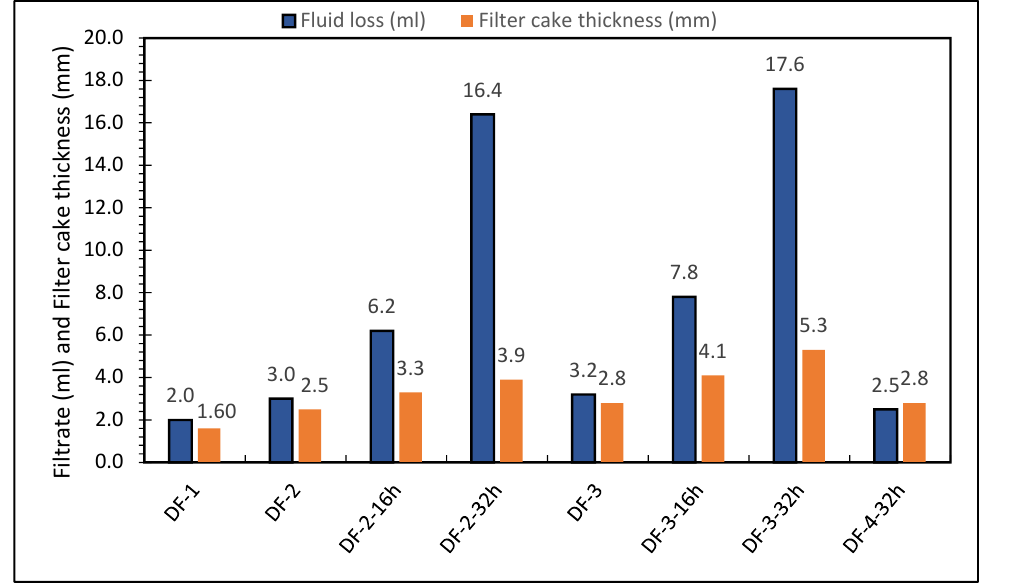
Figure 5. Fluid losses and filter cake thickness of filters obtained from of oil-based drilling fluids .